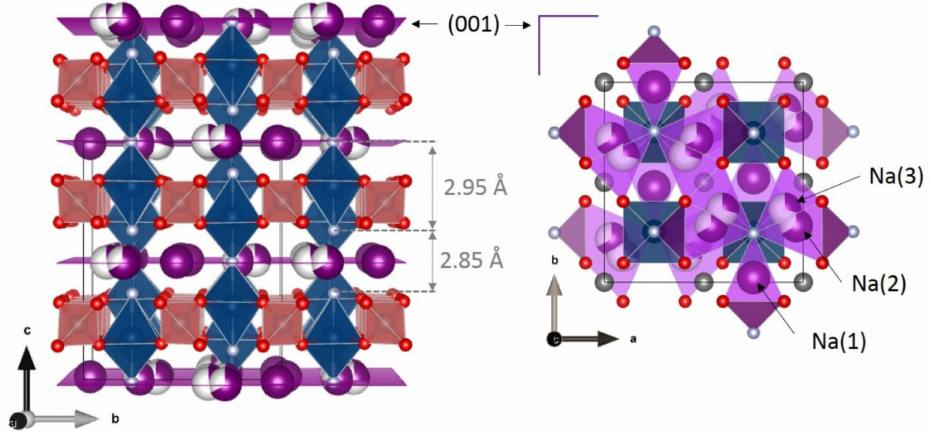
Figure 7. Structure of Na 3 V 2 (PO 4 ) 2 F 3 ( left ) and sodium distribution ( right ) [49]. Slow electrochemical galvanostatic cycling shows the presence of four distinct re- versible voltage-composition features at 3.70, 3.73, 4.18 and 4.20 V vs. Na + /Na (Figure 8) suggesting a complex phase diagram upon sodium extraction/reinsertion